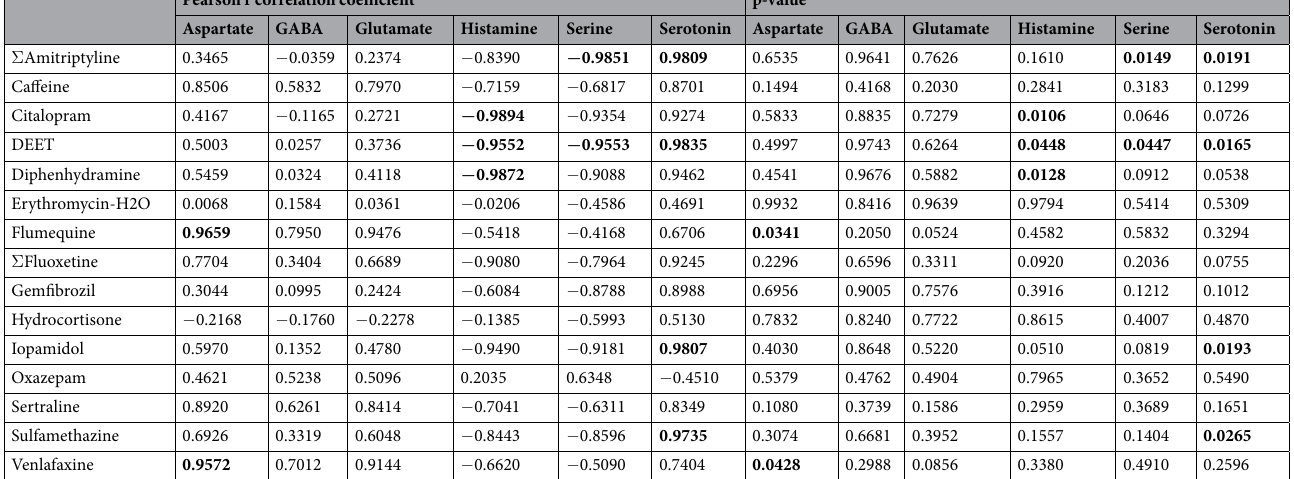
Table 1. Correlation matrix for PPCPs and mean neurotransmitter concentrations detected in goldfish plasma. Pearson r correlation coefficients in bold font were significantly correlated (p-value <